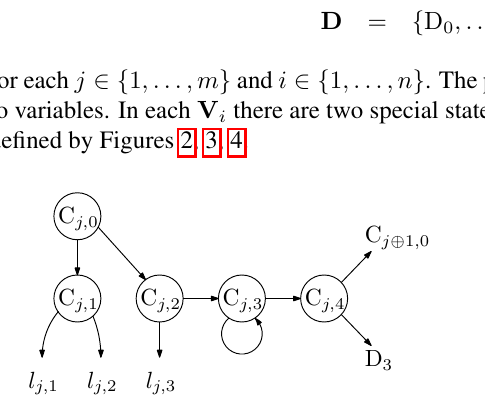
Fig. 2: The part C j . Note the edges that depend on Φ : they end in vertices labeled by literals from C j